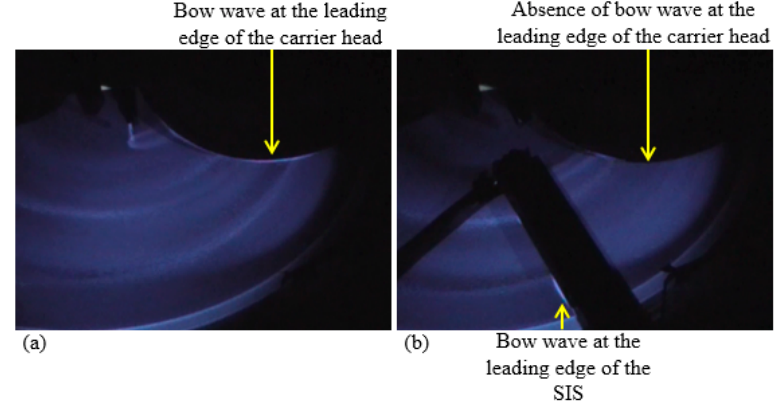
Figure 4. Bow wave formation on the polishing pad using ( a ) Point Application (PA) method and ( b ) the SIS.